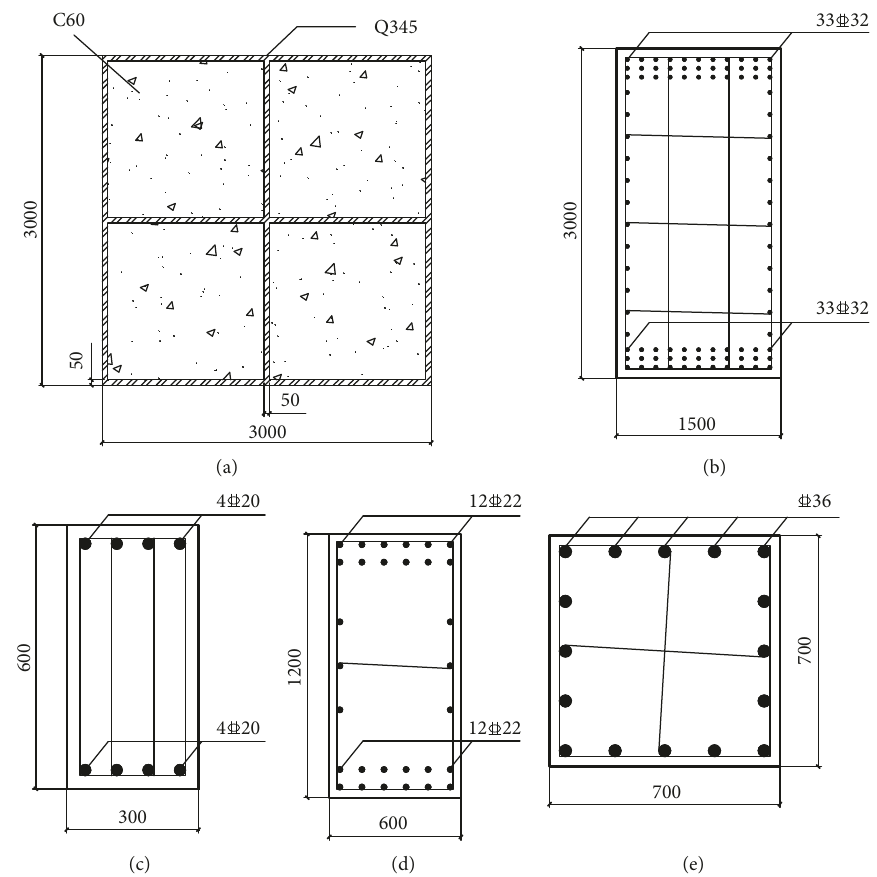
Figure 3: Schematic diagram of representative cross sections: (a) primary column; (b) primary beam; (c) secondary beam; (d) coupling beams with the width 600 mm; (e) secondary column.